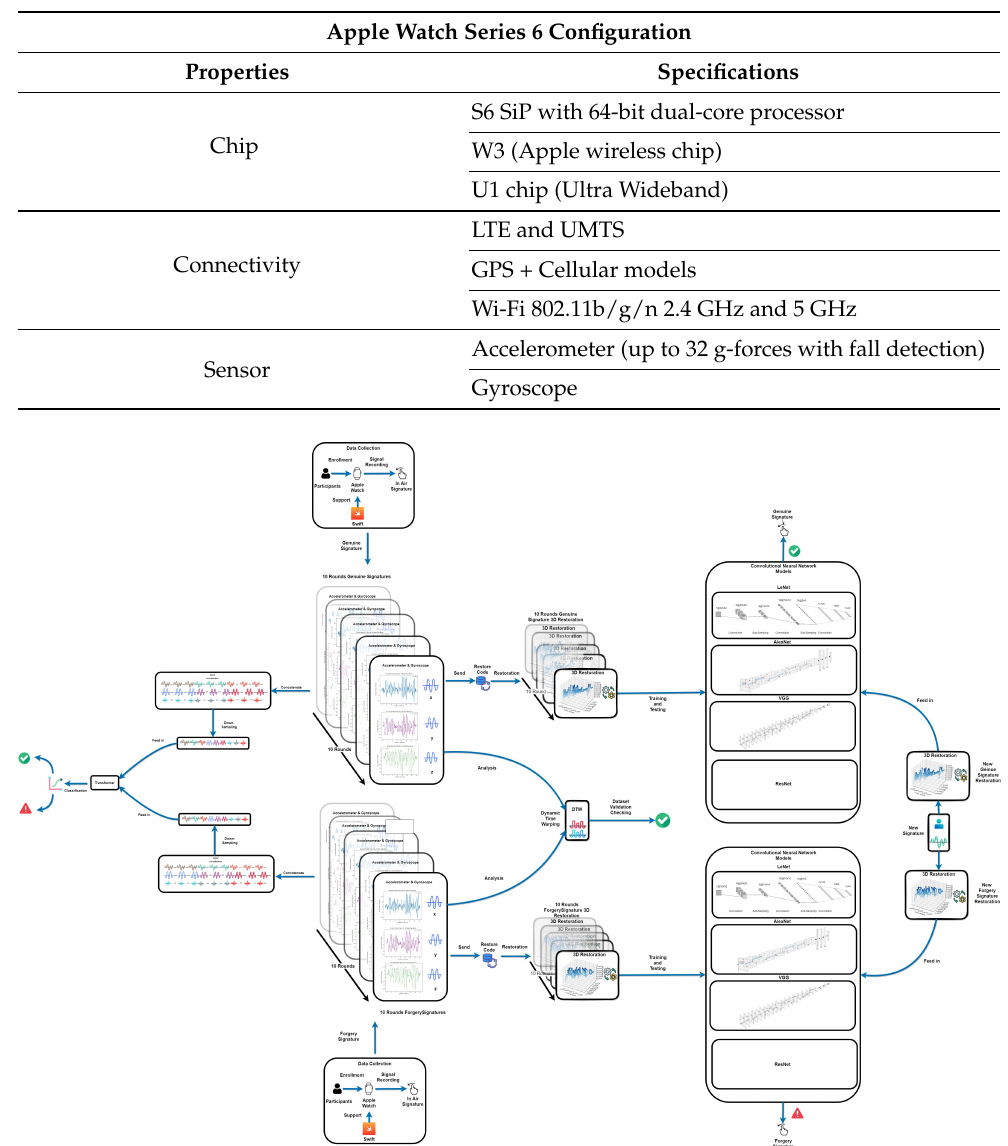
Table 2. The smartwatch technical characteristics used in the experiment.